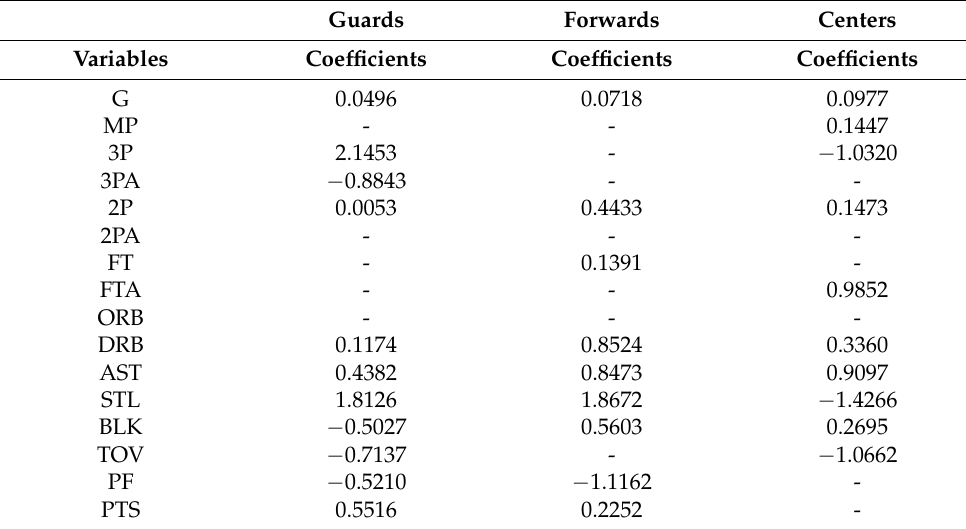
Table 3. Estimated beta coefficients of the statistically significant variables of the LASSO Models, divided by position of active players in the 2018-19 season. Guards Forwards Centers Variables Coefficients Coefficients Coefficients